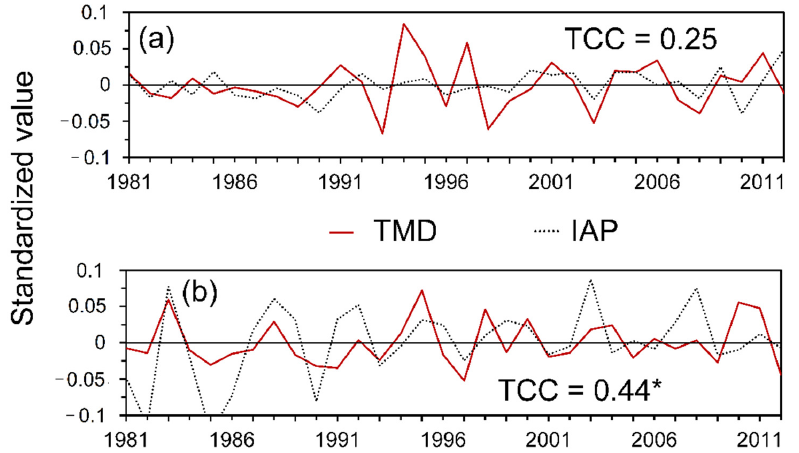
Figure 7. PC time series for shifting modes of the observed (solid red line) and IAP ‐ AGCM simulated (dotted black line) summer rainfall over Thailand during 1981–2012 for ( a ) TMD PC ‐ 1 versus IAP PC ‐ 2 and ( b ) TMD PC ‐ 2 versus IAP PC ‐ 2. A single asterisk (*) at the TCC value indicates significance at p < 0.05.